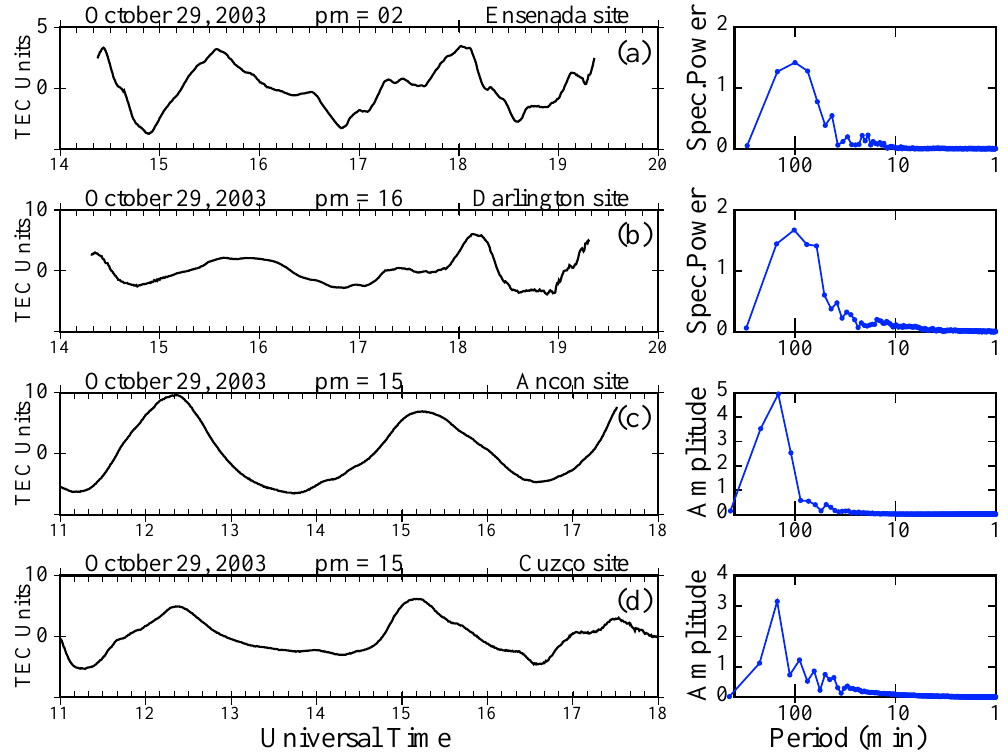
Fig. 1. The left panels show the values of the TEC perturbations observed at two stations located in the Northern Hemisphere (Ensenada and Darlington) and two stations situated in the Southern Hemisphere (Ancon and Cuzco). The right-hand panels display the power spectra of the TEC